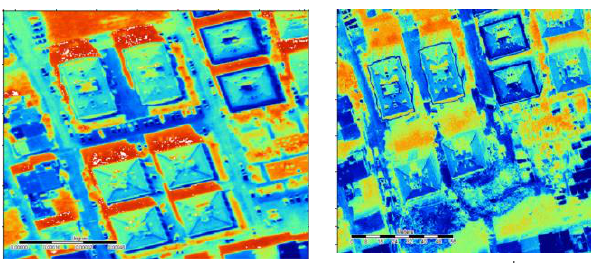
Figure 8. A sample from the optical image based 2 nd principal components (left: pre-EQ, right: post-EQ).